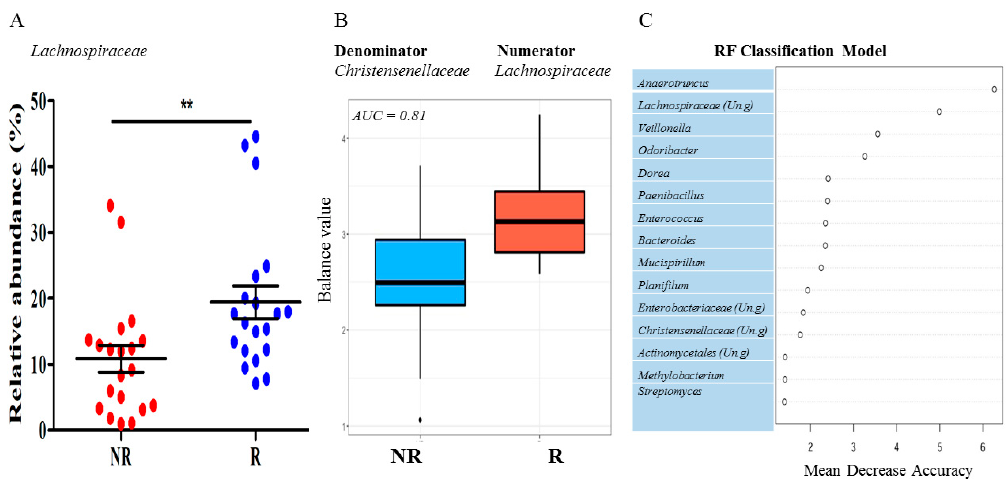
Figure 7. Microbial signatures associated with local recurrence of the estrogen receptor positive breast tumor after tamoxifen treatment in a rat model. ( A ) The abundance of the family Lachnospiraceae was significantly higher in rats with tumor recurrence. ( B ) A microbial signature consisting of Lachnospiraceae (numerator) and Christensenellaceae (denominator) accurately predicted the recurrence status. AUC = Area under the ROC (receiver operating characteristics) curve. R: with local recurrence; NR: without local recurrence. ( C ): The top 20 microbial predictors that contributed to the classification accuracy between the groups with (R) or without (NR) local recurrence. (Un.g) = unclassified genus. ** p < 0.01.